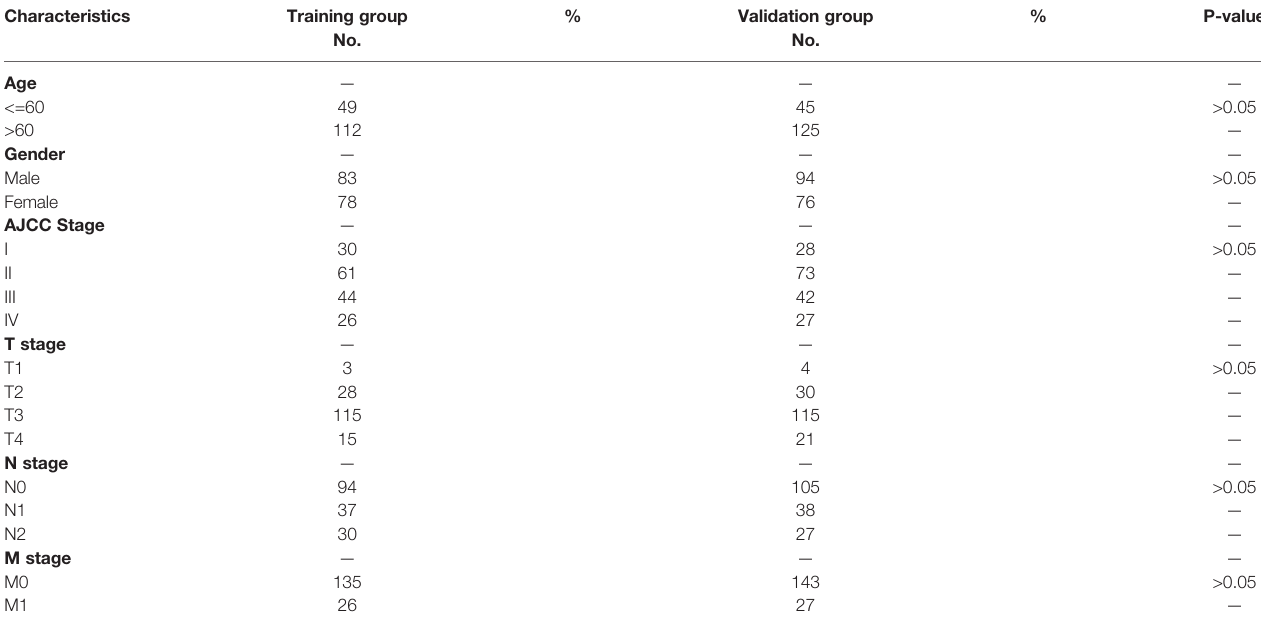
TABLE 1 | The clinical characteristics of colon cancer patients in the training and validation group.